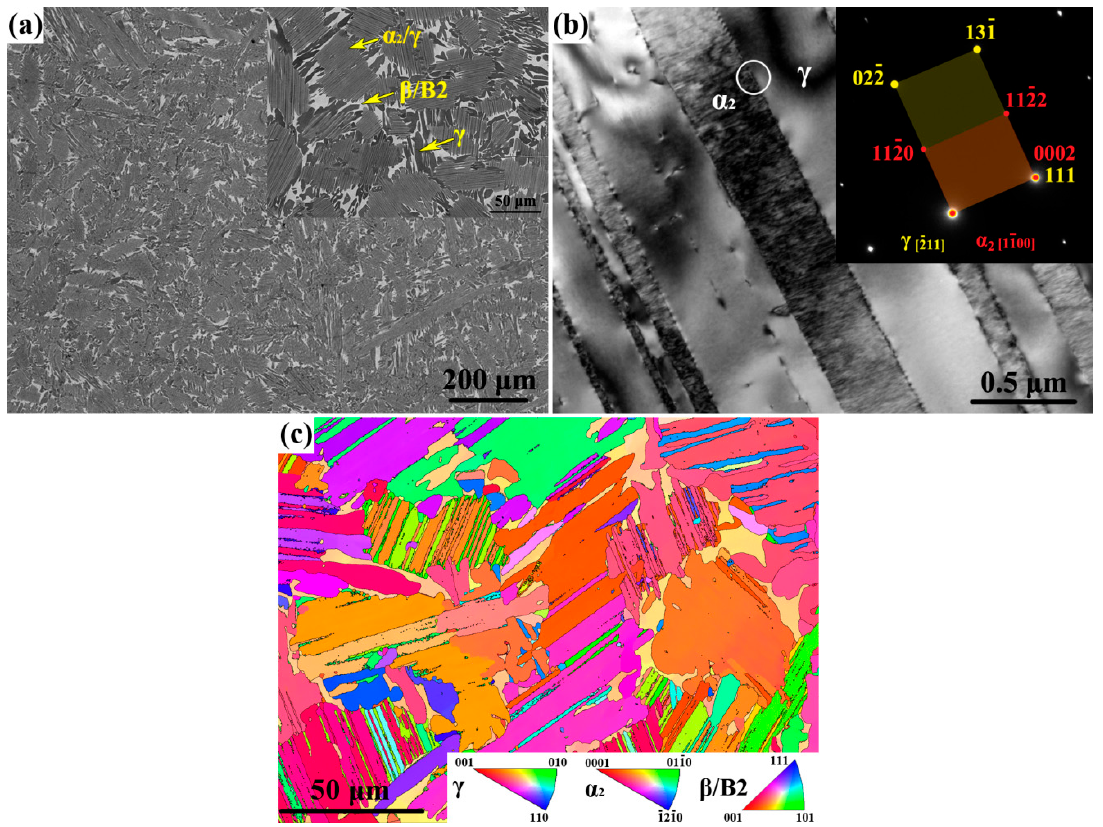
Figure 2. Microstructure of as-cast Ti-44Al-4Nb-1.5Cr-0.5Mo-0.2B alloy: ( a ) SEM image in BSE mode. The γ phase is dark gray, the α 2 / γ colonies are light gray, and β /B2 is white; ( b ) TEM image of the α 2 / γ lamella. The top-right corner image shows the corresponding SAED patterns of α 2 / γ lamella, and the white circle marks the selected area; ( c ) IPF map.